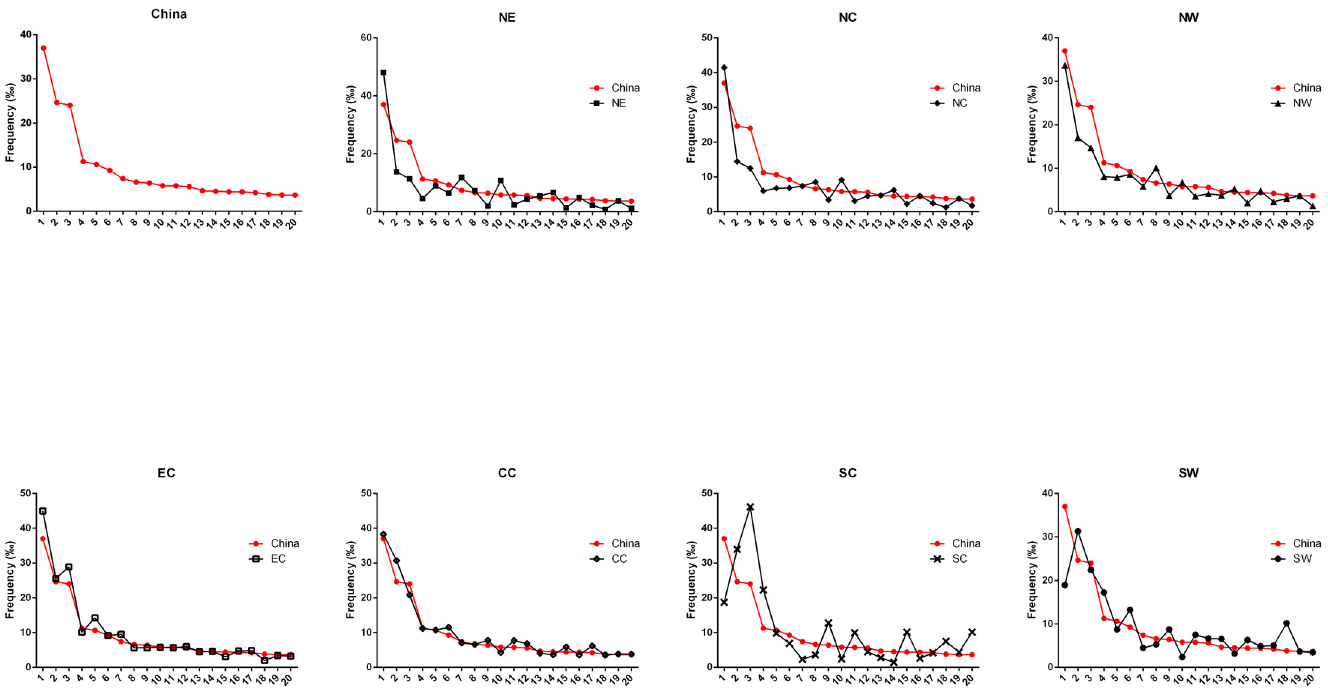
Fig 2. Distributions of the 20 most common HLA five-locus haplotypes in the seven geographic regions of China. (A) China; (B) Northeast China (NE); (C) North China (NC); (D) Northwest China (NW); (E) East China (EC); (F) Central China (CC); (G) South China (SC); (H) Southwest China (SW).